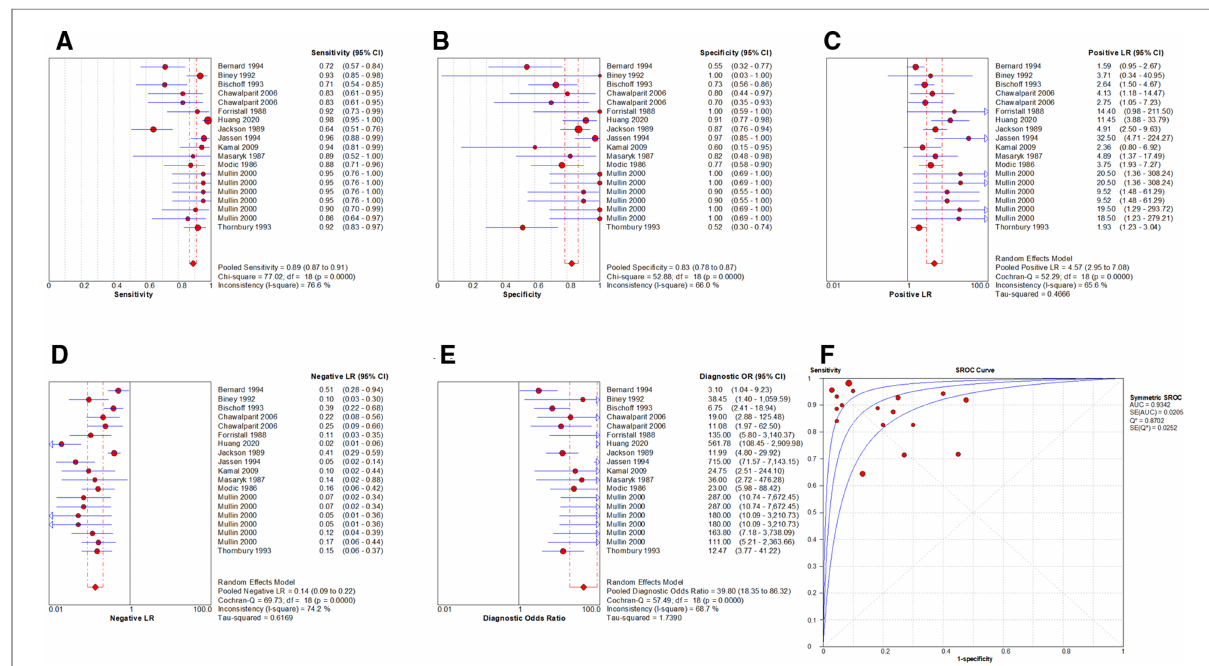
Figure 4 Forest plot of MRI for the diagnosis of LDH. The subgraph of ( A – F ) refers to Sen, Spe, +LR, − LR, DOR, AUC and Q*, respecti v